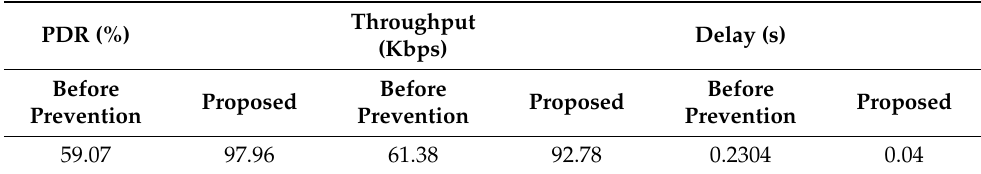
Table 7. Statistical test values.